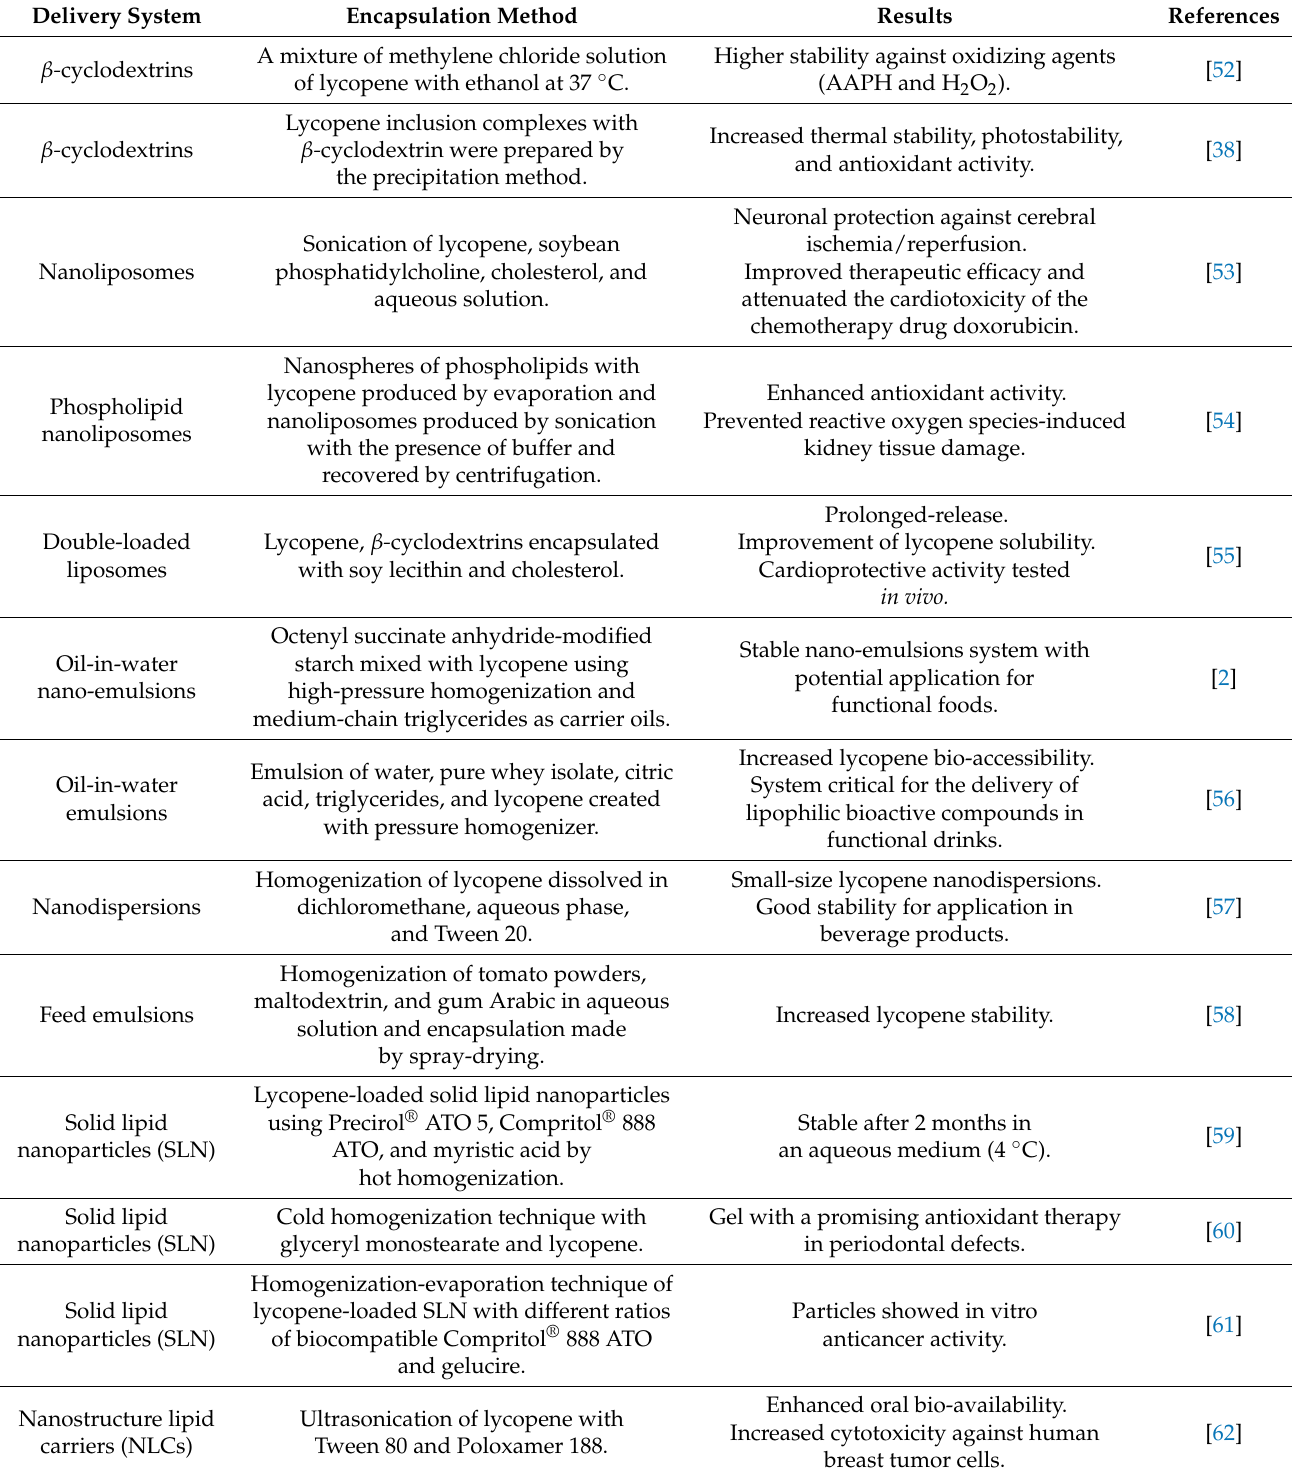
Table 4. Recent examples of methods used to encapsulate lycopene from 2017 to